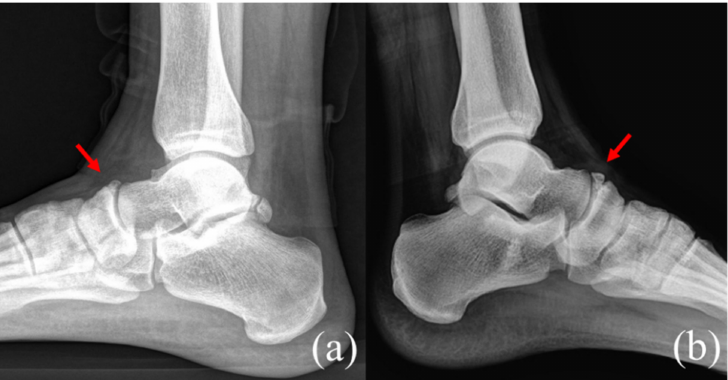
Figure 1. Plain lateral radiographs of the bilateral feet show the presence of well-corticated os supranaviculare (arrow) at dorsal aspect of the talonavicular without a definite fracture line. ( a ) the right and ( b ) left foot.